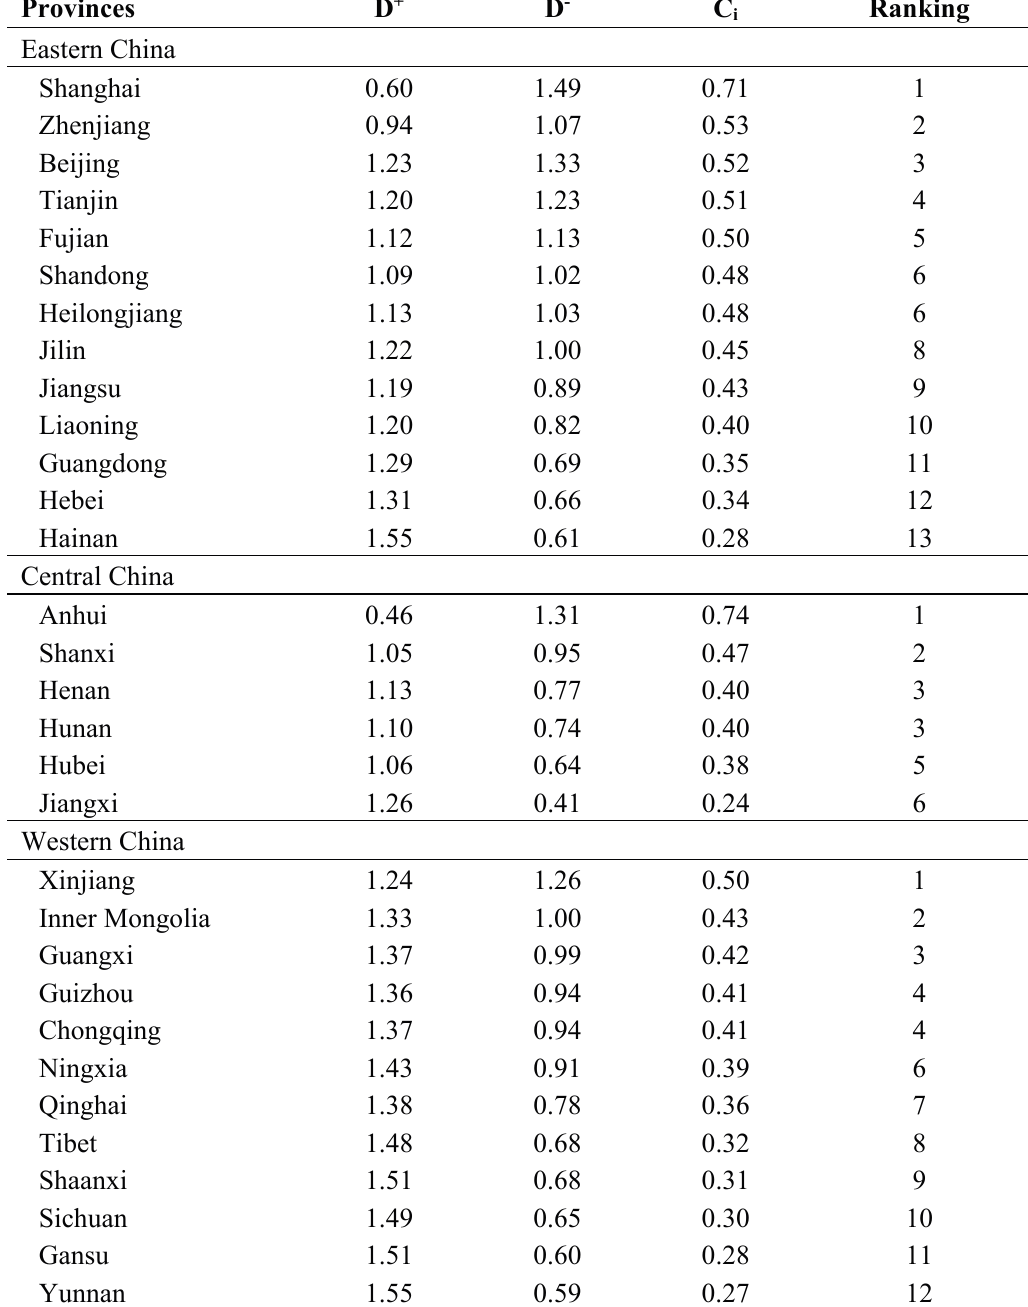
Table 7. Ranking of RPHC work in Eastern, Central and Western provinces of China. Provinces D + D - C